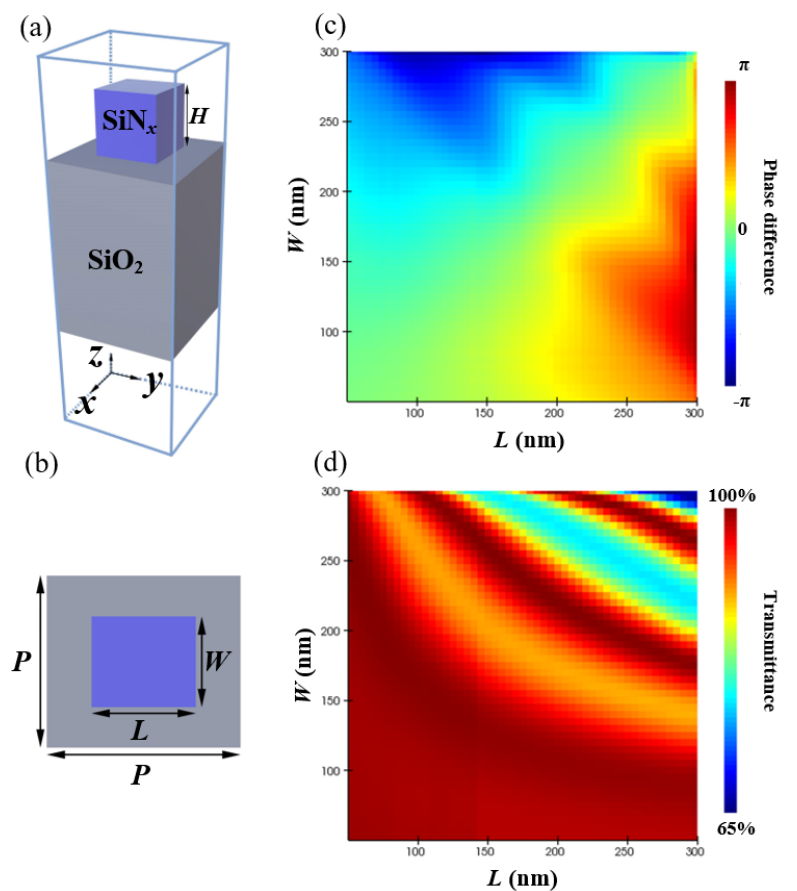
Figure 3. ( a ) Side-view and ( b ) top-view of the the unit cell: the period of a cell is P , and the length, width, and height are L , W , and H , respectively. ( c ) Simulated phase difference and ( d ) Simulated transmittance as a function of the nanofin size for the incident light of 0.7 µ